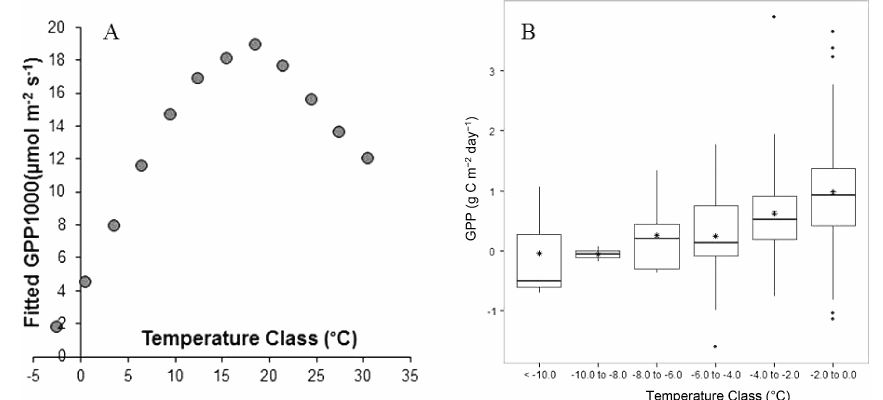
Figure 4. Observed temperature responses at Loobos. (a) Courtesy of P. Abreu: fitted GPP at a solar light intensity of 1000Wm − 2 (GPP1000, µmolm − 2 s − 1 ) based on half-hourly EC measurements (1997–2011) following Jacobs et al. (2007); (b) daily GPP (gCm − 2 day − 1 ) ob- served at Loobos calculated from site EC measurements, for days with average daily temperatures <0 ◦ C and total net radiation received >2MJday − 1 ( n = 175).